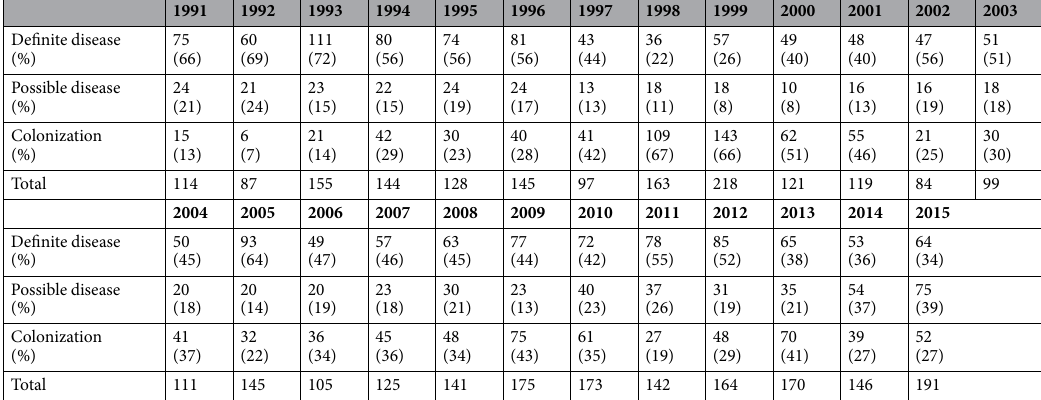
Table 2. Annual number of NTM isolates in the study period. Percentages row wise each year (percentages differ 99–101 due to rounding).